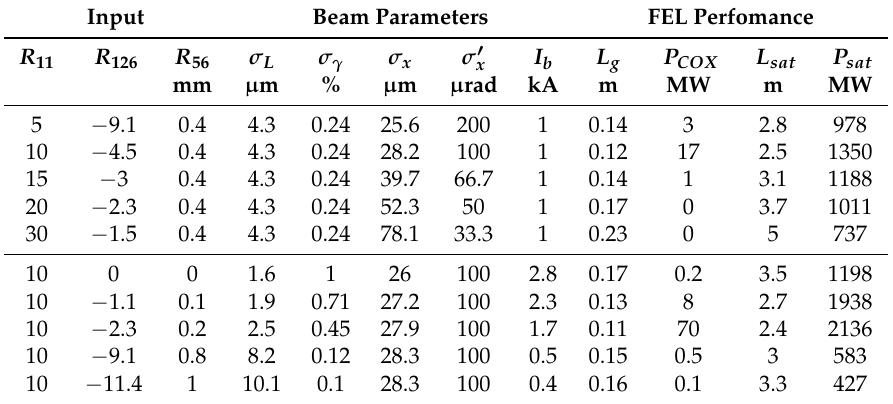
Table 4. FEL performance as the magnification of the beam (source to undulator center) and chicane strength are varied. L g the FEL gain length, L sat the FEL saturation length, P sat the saturation